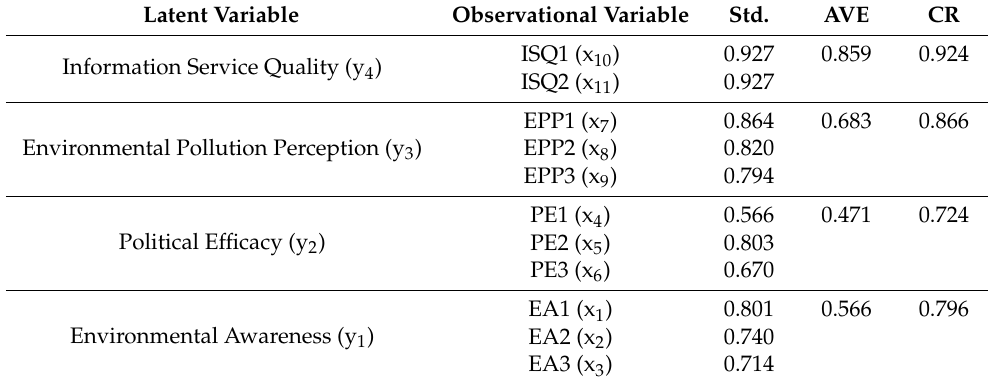
Table 3. Reliability and validity analysis of measurement model.